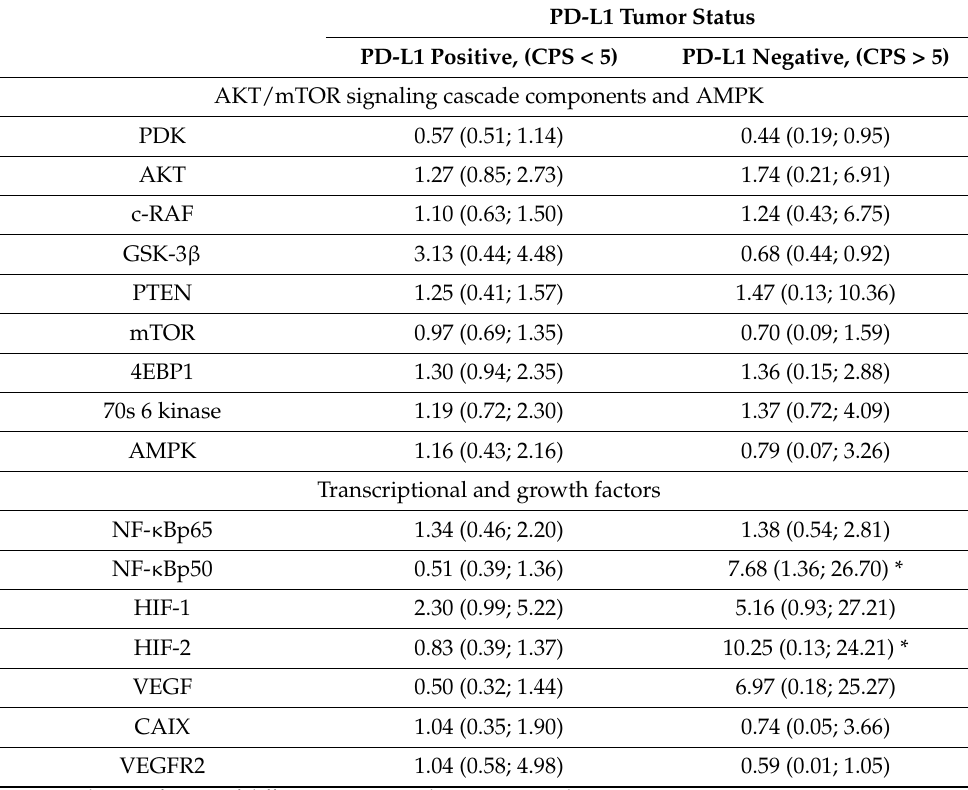
Table 2. Molecular markers in GC tissues’ gastric cancer depend on IHC PD-L1 status, Me (Q1;